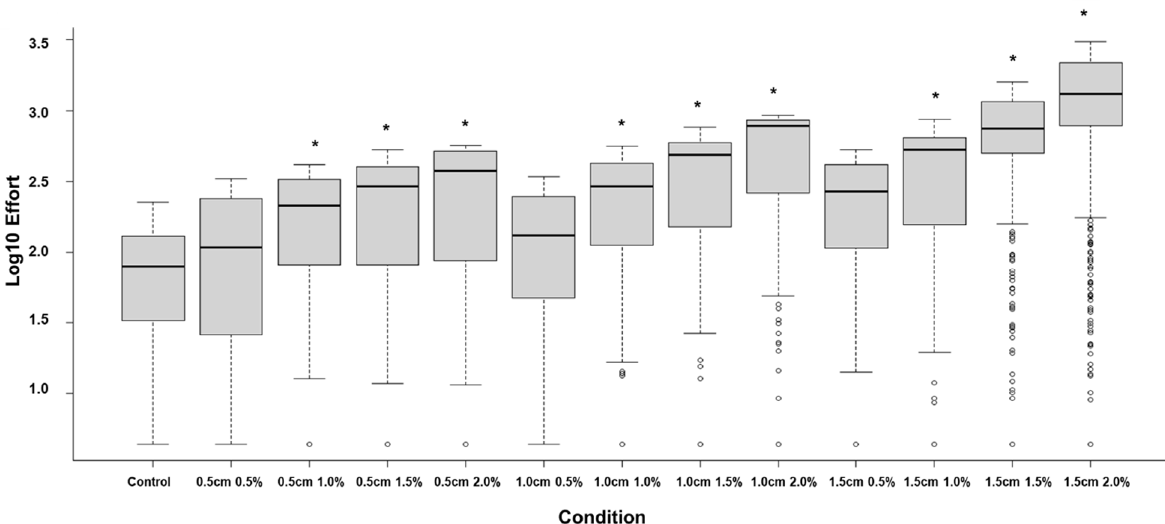
Figure 11. Stress–strain curve with variations of fiber content and fiber length ( a ) 5 mm; ( b ) 10 mm; ( c ) 15 mm .